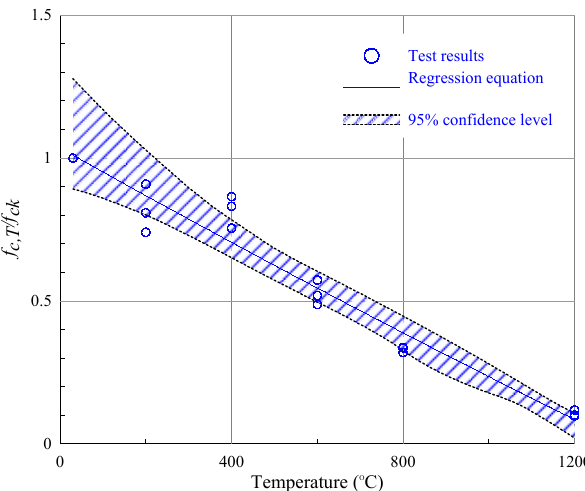
Figure 12. Relative residual strength at various temperatures.